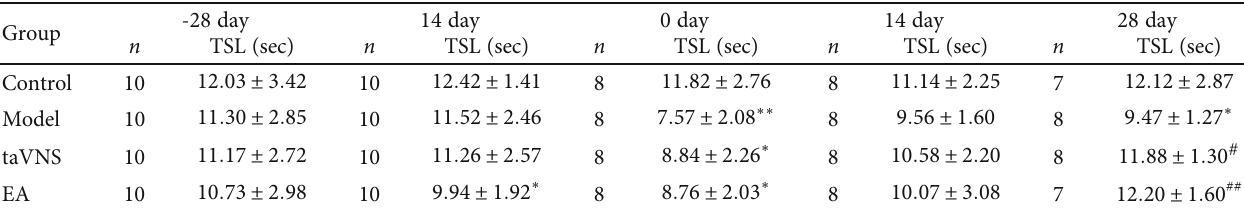
Table 4: Comparison of thermal stimulation latency in each group at di ff erent time points ( (cid:1) x ± s ). Group